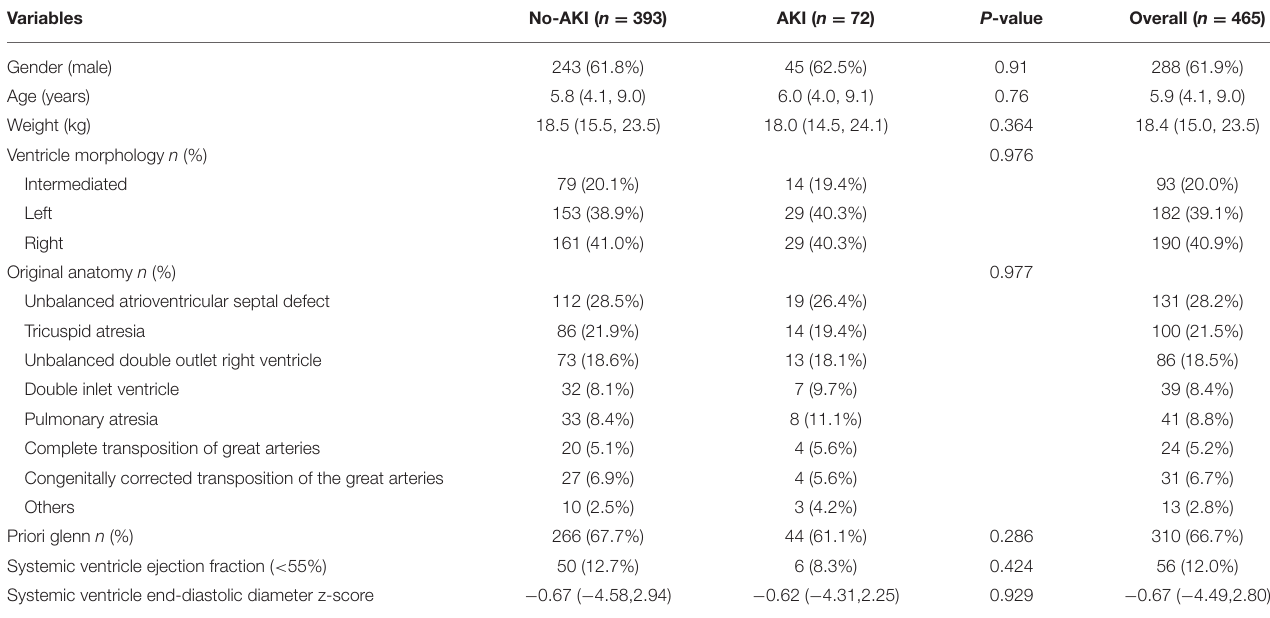
TABLE 2 | The demographic data of the study patients.